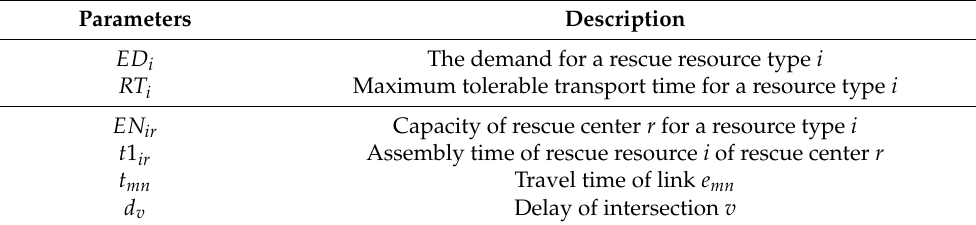
Table 2. Parameters of rescue demand and rescue